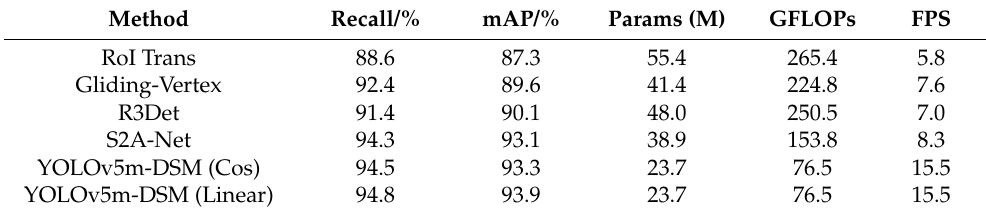
Table 2. Comparison of YOLOv5m-DSM and rotating frame detection methods.